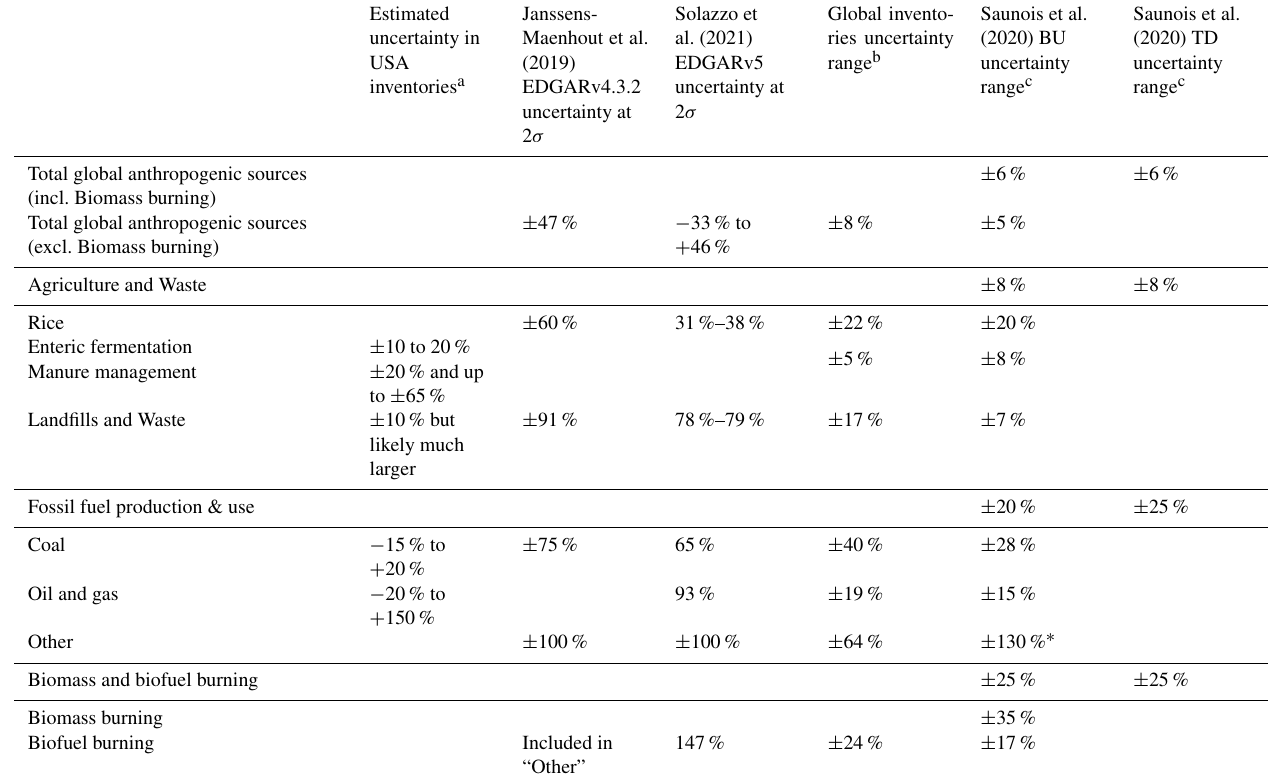
Table 5. Uncertainties estimated for CH 4 sources at the global scale: based on ensembles of bottom-up (BU) and top-down (TD) estimates, national reports, and specific uncertainty assessments of EDGAR. Note that this table provides uncertainty estimates from some of the key literature based on different methodological approaches. It is not intended to be an exhaustive treatment of the